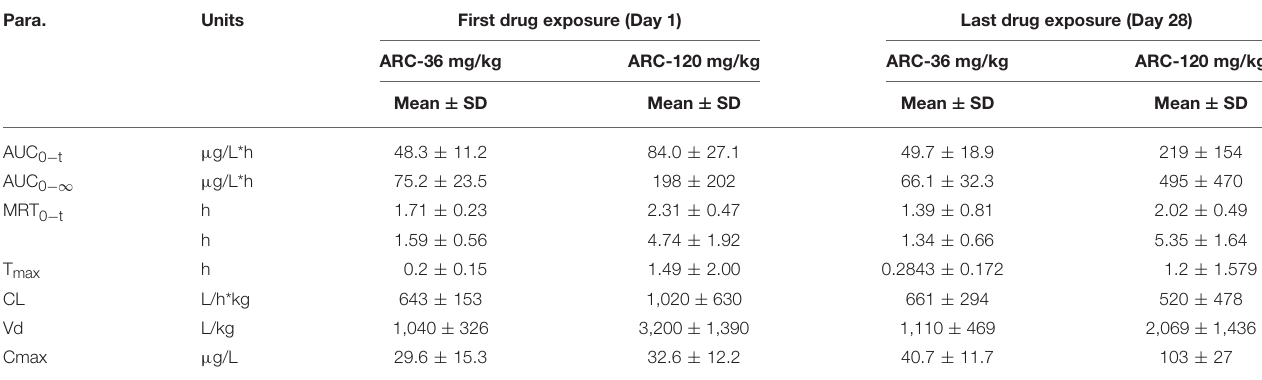
TABLE 9 | Toxicokinetic parameters of Arctigenin (36- and 120 mg/kg) administration by gavage (i.g) in rats at the first drug exposure (day 1) and last drug exposure (day 28) ( n = 10, 5 female, 5 male per treatment group, results were presented as Mean ± SD).